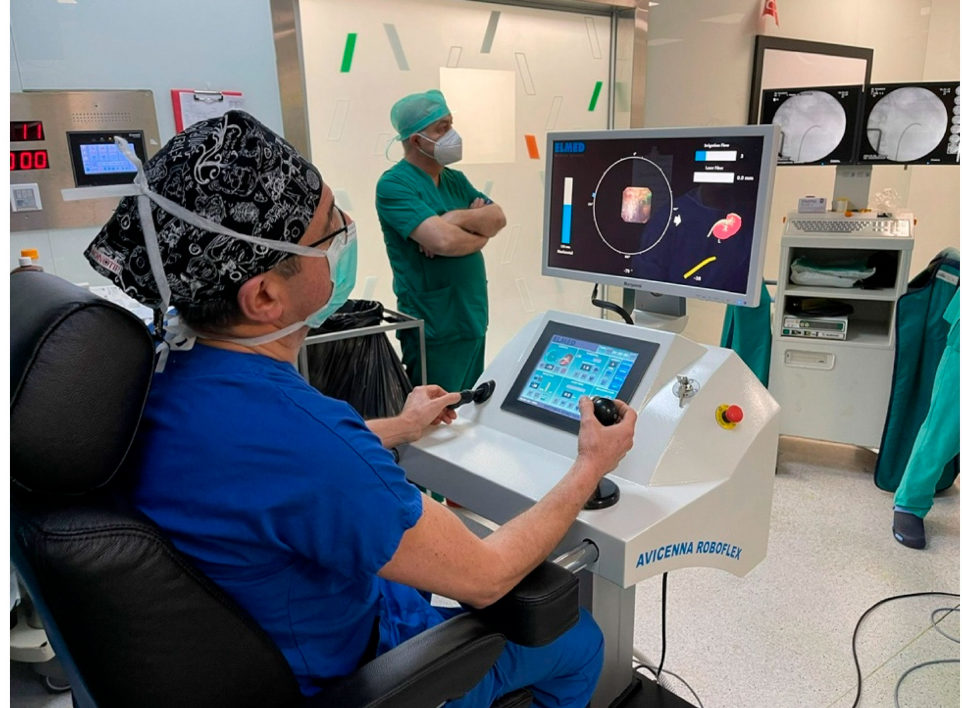
Figure 2. Surgeon working at the Roboflex Avicenna